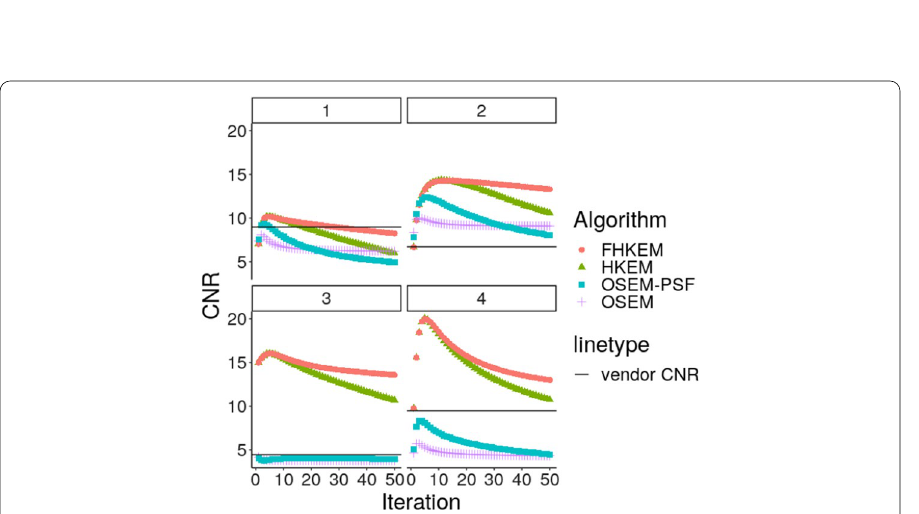
Fig. 8 Contrast to noise ratio (CNR) comparison between OSEM, OSEM‑PSF, HKEM and FHKEM frozen at the 72nd sub‑iteration for the hottest lesion. The black line represent the CNR estimated on the vendor reconstructed image at iteration 2. Legend as per Fig.